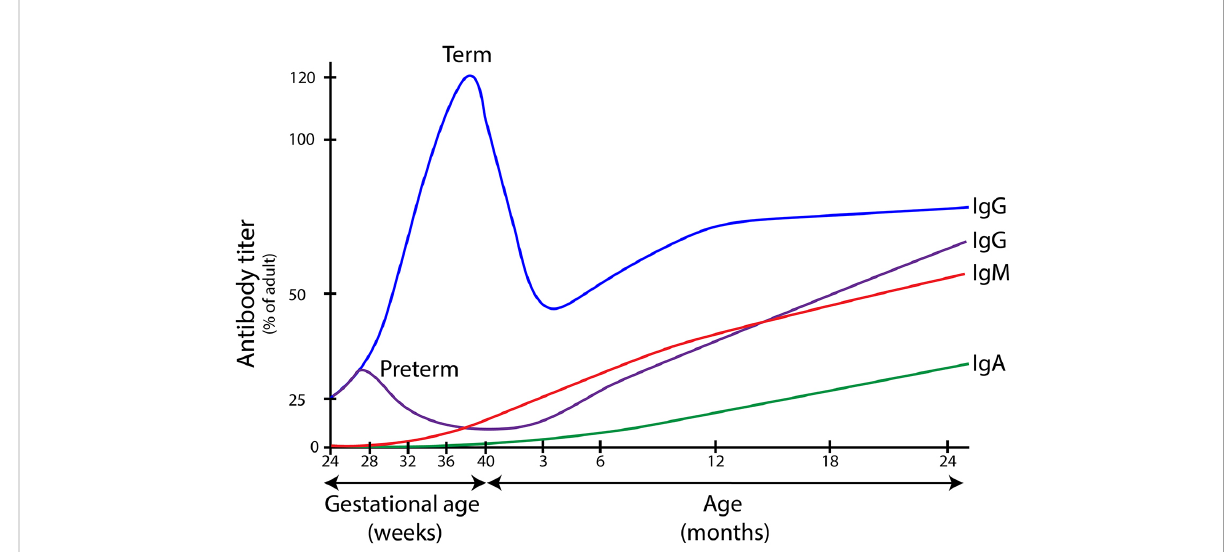
FIGURE 1 Immunoglobulin serum concentrations in different age groups. Levels of immunoglobulins A, G and M in different stages of life. IgG is actively transported over the placenta during pregnancy, with a peak between 36 and 40 weeks of gestational age. Children born before this age have lower levels of IgG at birth and are at increased risk for bacterial infections. In new born infants, IgG wanes over time which leads to a window of increased susceptibility to infection (between the age of 3 months and 2 years in term infants). IgA and IgM are not transferred over the placenta, which means that children are dependent on endogenous antibody production to reach protective serum IgA and IgM concentrations. Immunoglobulin levels are depicted as percentage of average adult serum levels (median adult IgG 10.9 g/L; median adult IgA 1.3 g/L median adult IgM 2.3 g/L. The fi gure is a composite of information from many sources (12 –